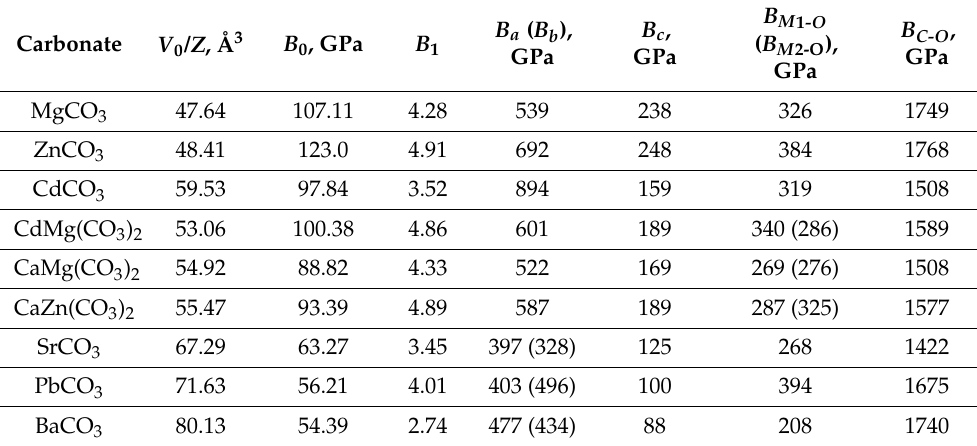
Table 2. Equilibrium volume of unit cell per one formula unit V 0 / Z , volume compression modulus B 0 and its pressure derivative B 1 , linear compression moduli along the a ( b for the aragonite structure), c - B a ( B b ), B c crystallographic axes and the metal-oxygen B M-O interatomic distances (M1-O, M2-O for double carbonates M1M2(CO 3 ) 2 ), and B C-O for carbon-oxygen